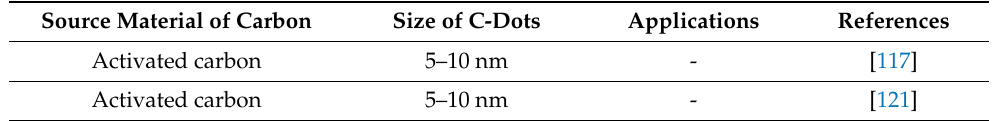
Table 9. Synthesis of C-dots by the ultrasonic